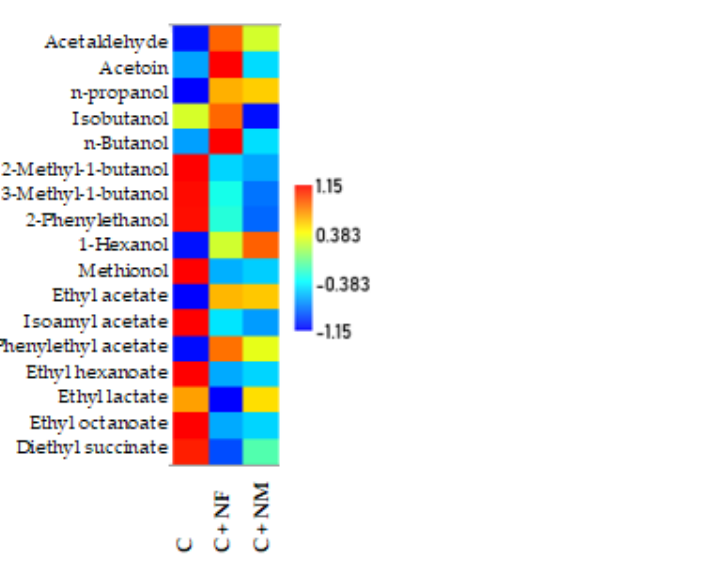
Figure 4. Heatmap based on all the volatile compounds detected in the experimental wines obtained by the mixed starters with S. cerevisiae EC1118 (C) and H. osmophila ND1 in two different formulations (NF—free cells; NM—microencapsulated cells) in comparison to the single starter wine with EC1118 (C). Colors represent the range of Z -scores (calculated over the rows), with blue indicating lower than average production, light green indicating average production and red indicating higher than average production of each compound.